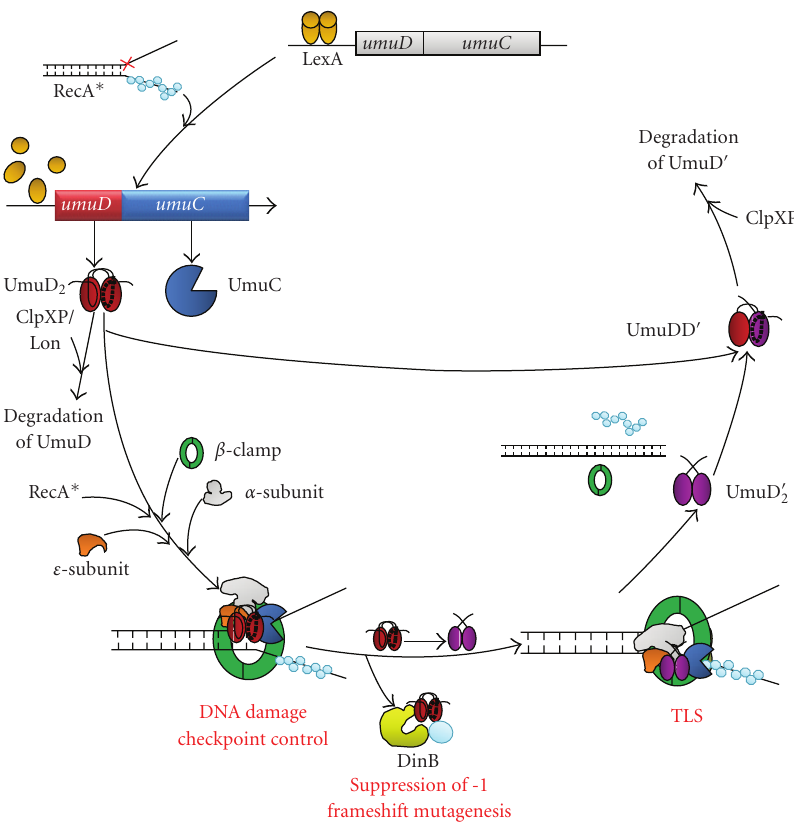
Figure 1: Life cycle and interactions of UmuD gene products. Details are described in the